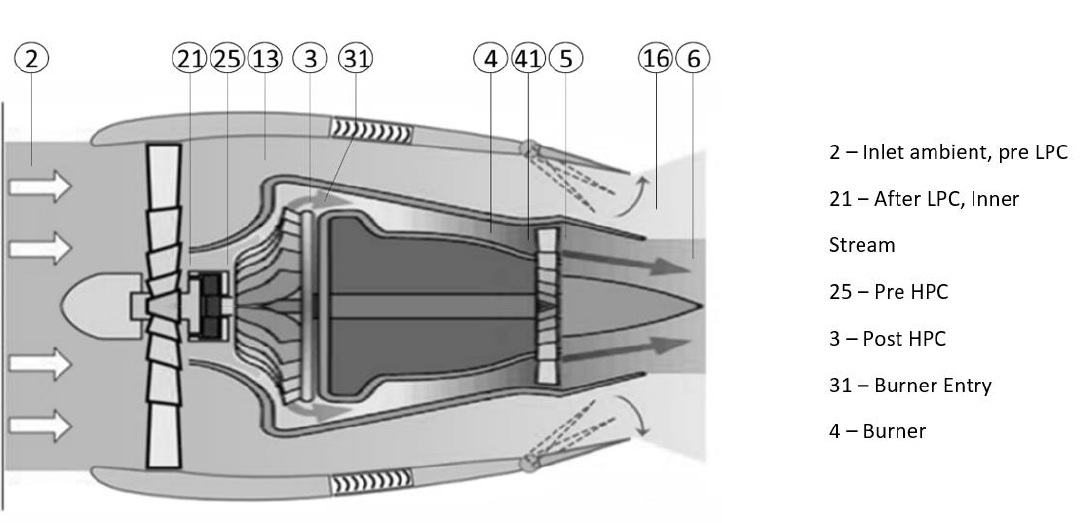
Figure 6. The converted turbofan engine schematic with the associated station numbering.